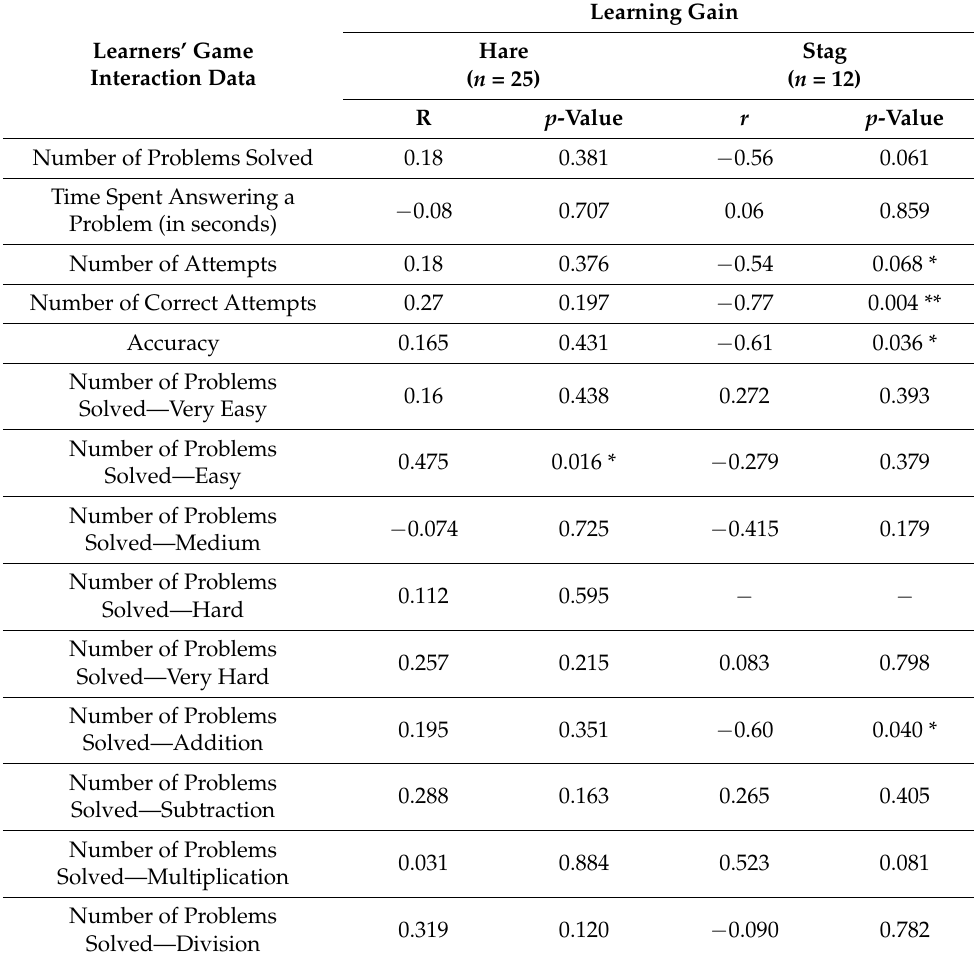
Table 7. Spearman’s rho rank correlation showed that the number of problems solved by hare hunters was positively related to their learning gain. Meanwhile, the interactions of the stag hunters were negatively related to their learning